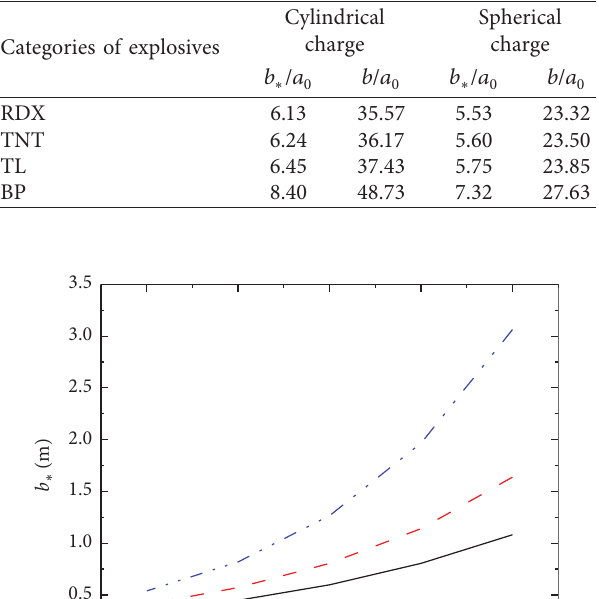
Table 5: Calculation results of different explosives.